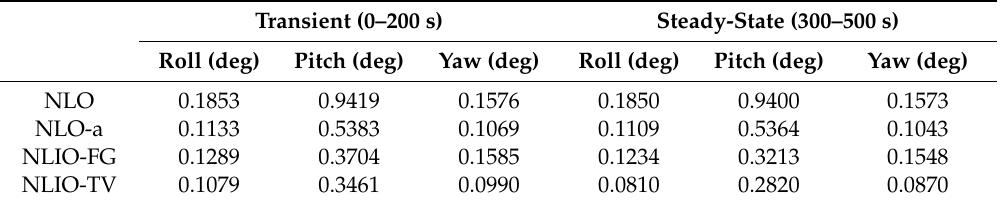
Table 4. RMSEs of attitude for all the observers in Case